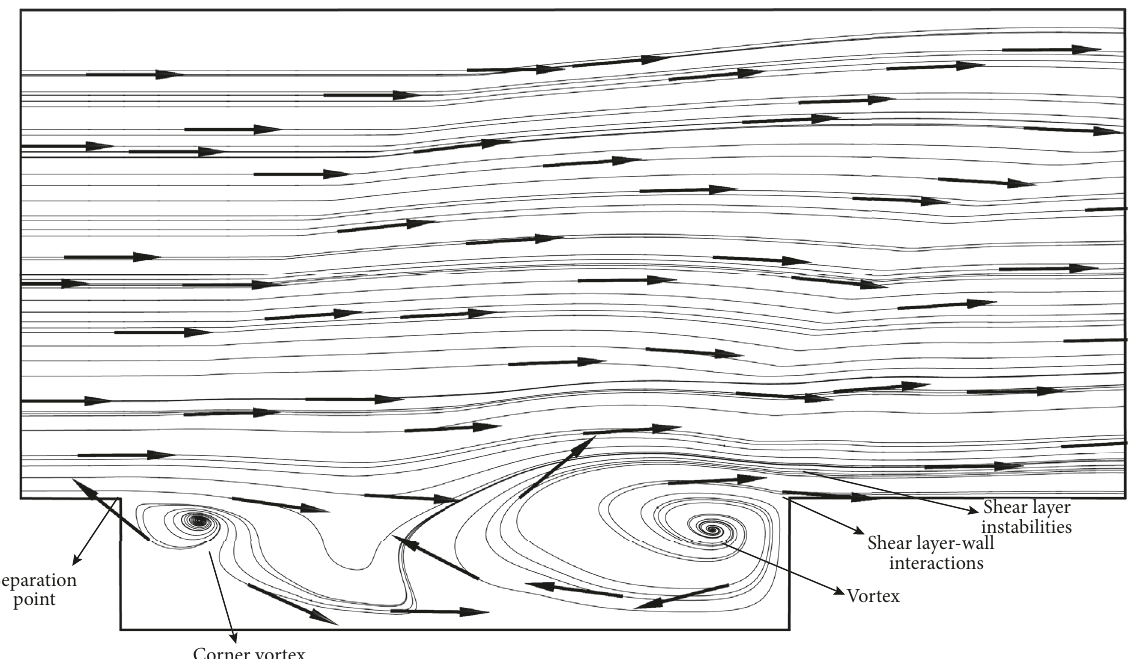
Figure 3: Supersonic cavity flow dynamics.